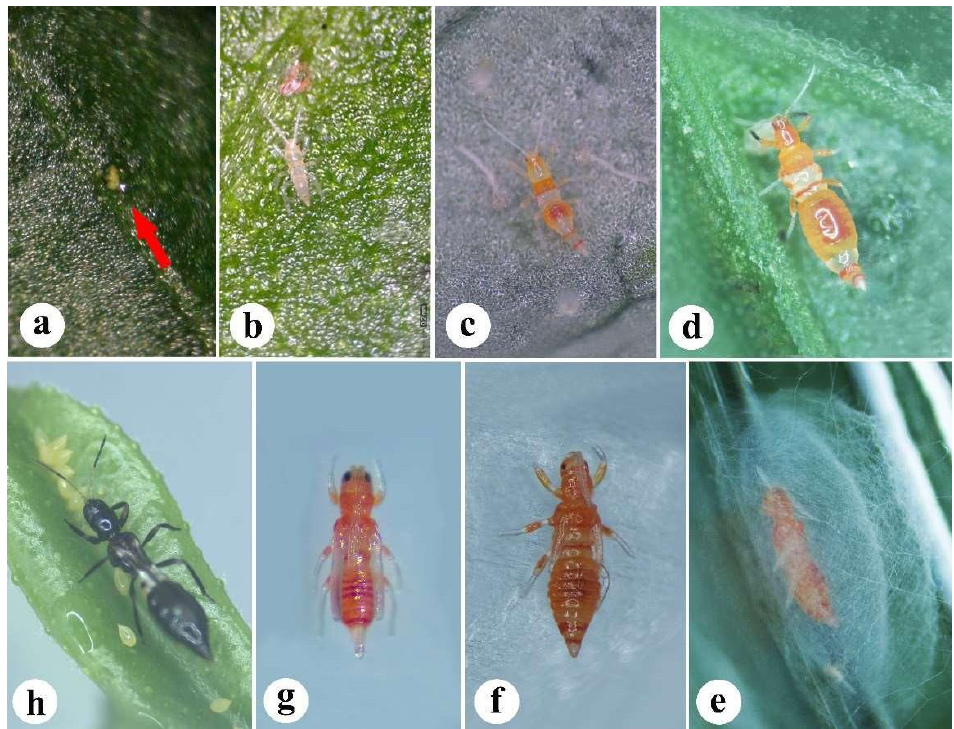
Figure 2. Different stages of Franklinothrips vespiformis . ( a ) Egg; ( b – d ) larva: ( b ) Newly emerged larva; ( c ) first instar larva; ( d ) second instar larva; ( e – g ) pupal stages: ( e ) pupa into cocoon; ( f ) Pupal stage 1; ( g ) pupal stage 2; ( h ) adult.